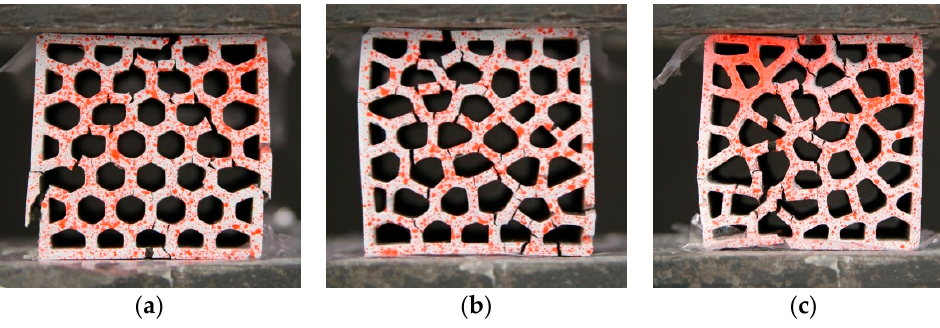
Figure 26. Crack pattern of the LCCCs, ( a ) R0, ( b ) R3 and ( c ) R7.